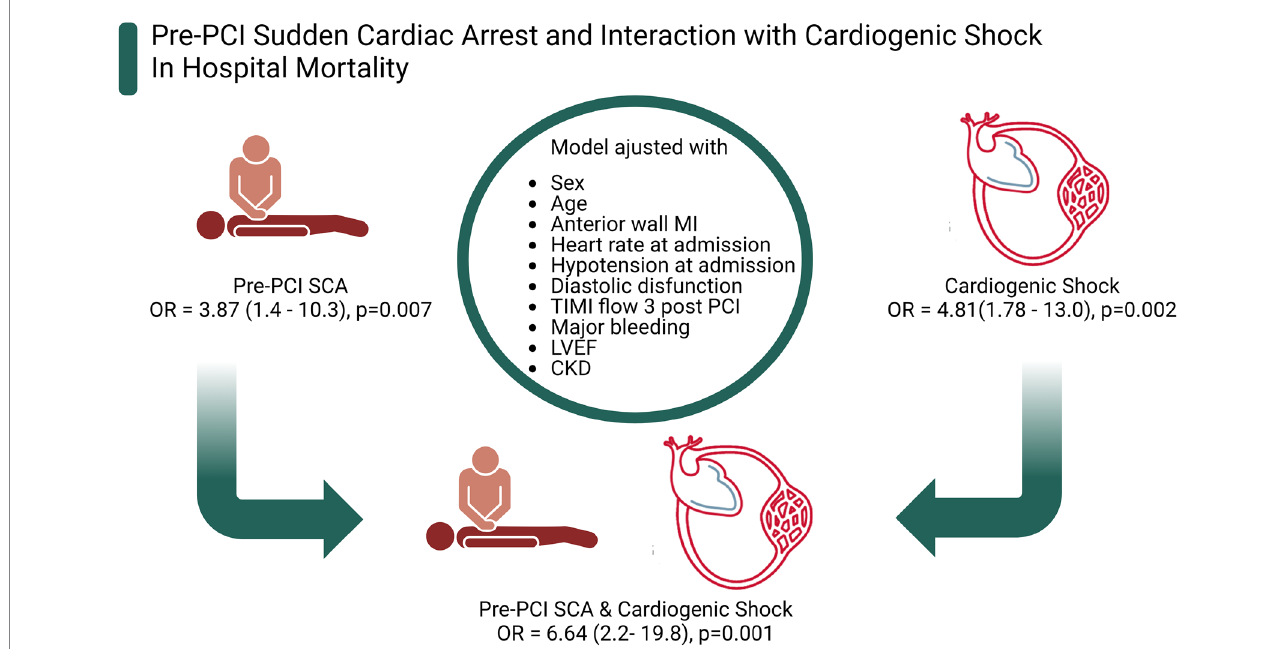
FIGURE 2 Pre-PCI sudden cardiac arrest and interaction with cardiogenic shock in hospital mortality. Figure created with BioRender.com.